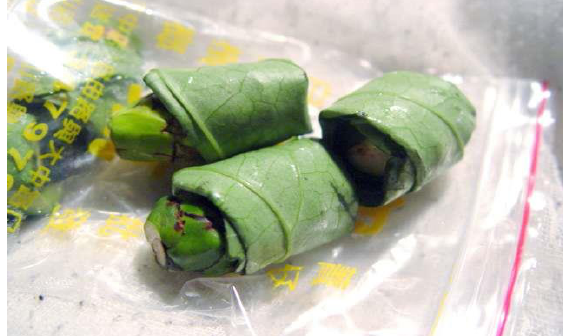
Figure 13. Paan marketed in Taiwan